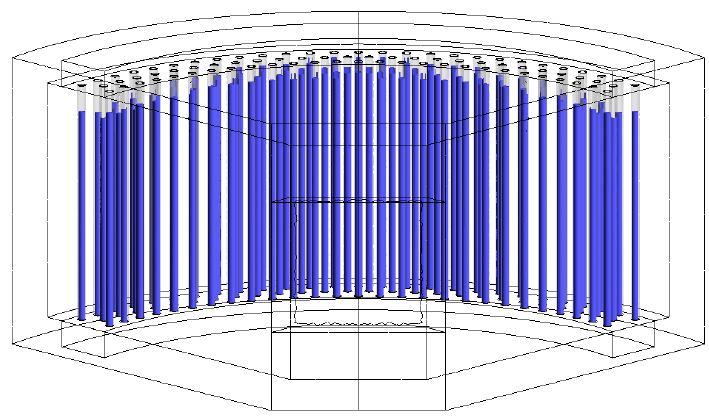
Figure 12. Volume of ferrite (inside tubes) where temperature is higher than 900 °C.